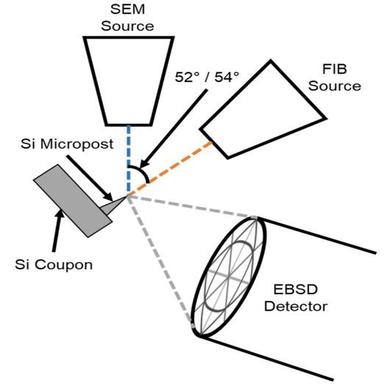
Schematic diagram (not to scale) of the experimental setup used for the TKD experiments.